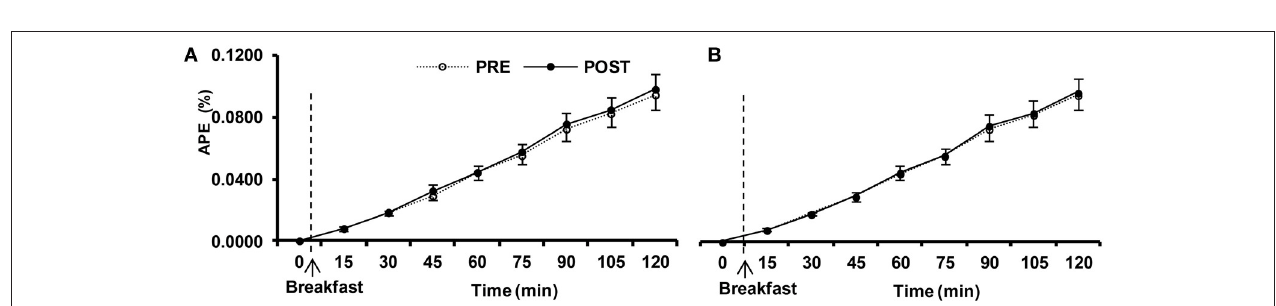
FIGURE 4 | Relative change ( 1 ) in postprandial circulating glucose, and serum insulin values before (PRE) and after (POST) the 10-day normoxic (NORMOXIC; A) and hypoxic (HYPOXIC; B) confinement. Values are mean ± SEM. *Indicates significant ( p < 0.05 ) difference between PRE and POST confinement; #indicates significant ( p < 0.05 ) differences over time from the fasted state; § indicates significant ( p < 0.05 ) differences over time from the peak values.